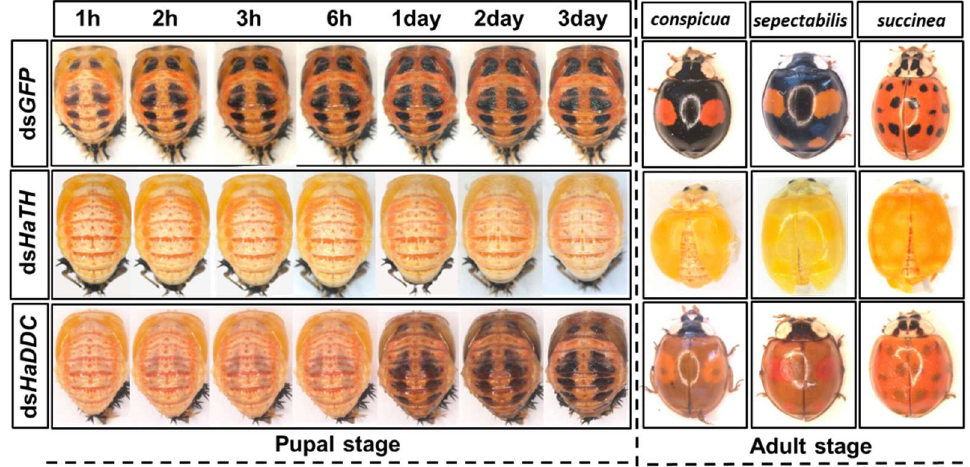
Figure 2. Time-dependent suppression of HaTH transcript in fourth instar larvae of H. axyridis injected with ds HaTH at 300 ng/larva or ds GFP at 300 ng/larva as determined by RT-qPCR ( a ), time-dependent mortality ( b ), pupation rate ( c ), and eclosion rate ( d ) in ds HaTH and ds GFP -injected larvae. The relative transcription levels (%) are presented as the mean and SE of three replicates with three insects. There were three replicates in the determination of mortality, pupation rate, and emergence rate, each of which had at least 30 fourth instar larvae. Notability analysis was based on SPSS (v. 22, IBM Corp. Armonk, NY, USA) followed by One-Way ANOVA ( p < 0.05) within the same time point. Asterisk indicates a significant difference in the rate of eclosion and relative transcript level of HaTH between insect injected with ds HaTH and ds GFP (*: significant difference; **: extremely significant difference).